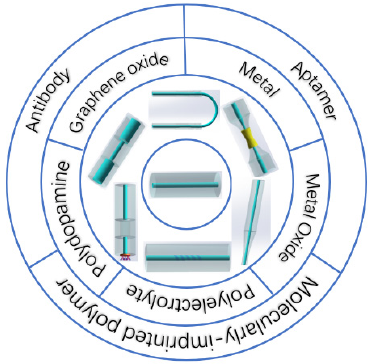
Figure 17. The structures of fiber biosensors and the modification methods.